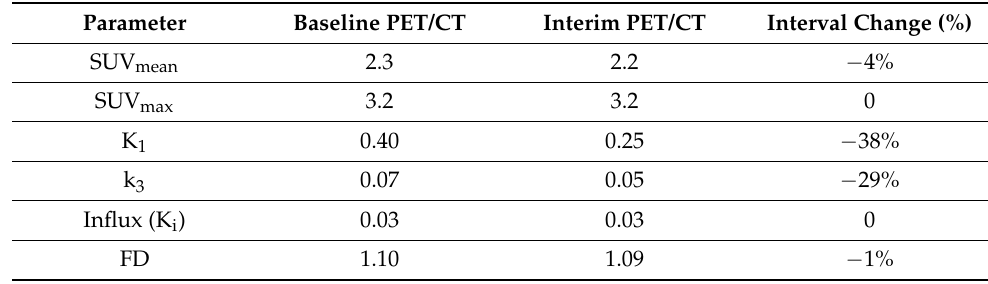
Table 6. Median values of the 18 F-FDG semiquantitative and quantitative parameters, derived from the spleen, before and after two cycles of anti-PD-1 therapy, as well as their interval changes (%) as a response to treatment. The units of parameters K 1 , k 3 and influx are 1/min. SUV mean , SUV max and FD have no